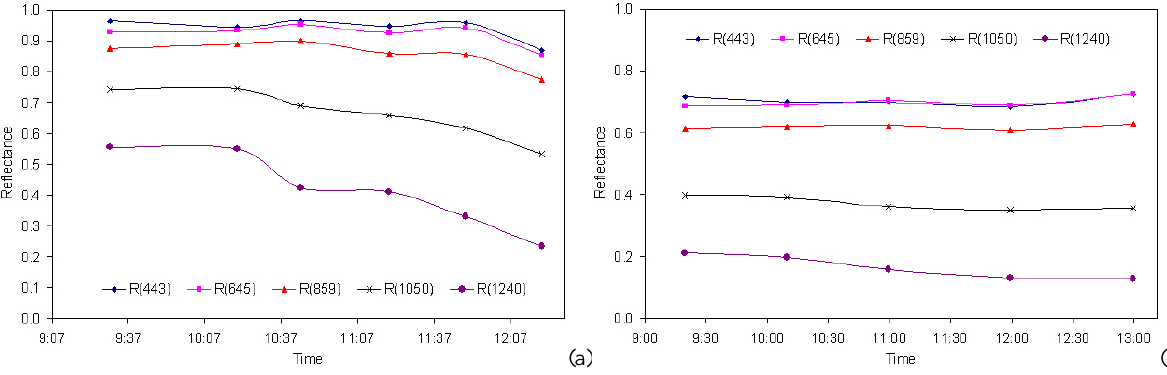
Fig. 9. Field measured reflectances of snow at wavelength 443, 645, 859, 1050 and 1240nm (a) snow Type-I and (b) snow Type-II.